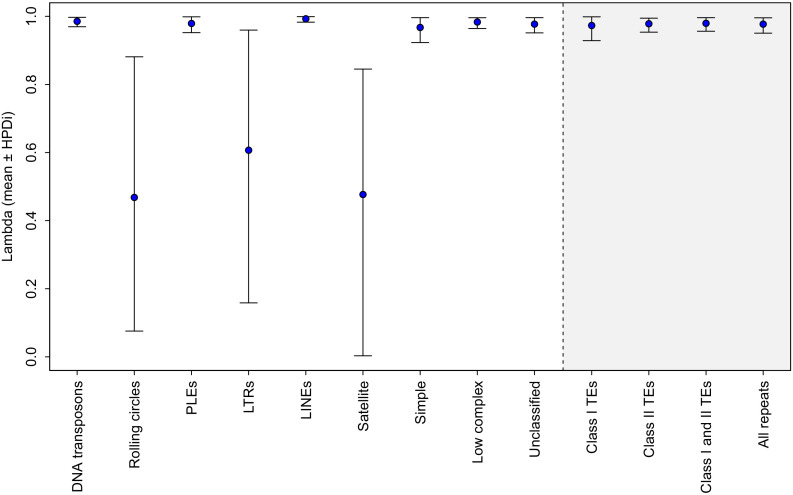
Phylogenetic signal (λ) in TE load variation among rotifer lineages, defined as the proportion of the total variance in TE load attributable to the phylogeny (de Villemereuil and Nakagawa, 2014).The value of λ indicates how well the phylogeny predicts patterns of covariance among species (Pagel, 1994). Values closer to one indicate a stronger phylogenetic effect, consistent with TE content evolving according to neutral genetic drift (i.e. under a constant-variance Brownian motion model). Error bars show the 95% credible interval around the mean value of λ from 2000 stored samples of the posterior.